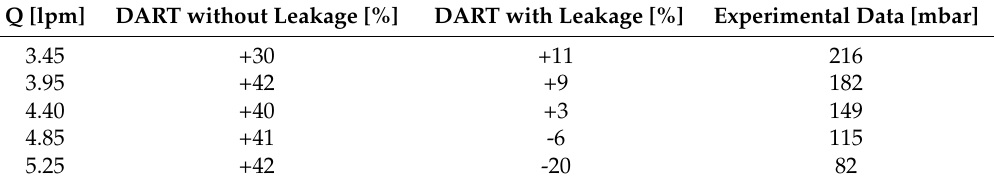
Table 4. Comparison between pressure rise of experimental data and